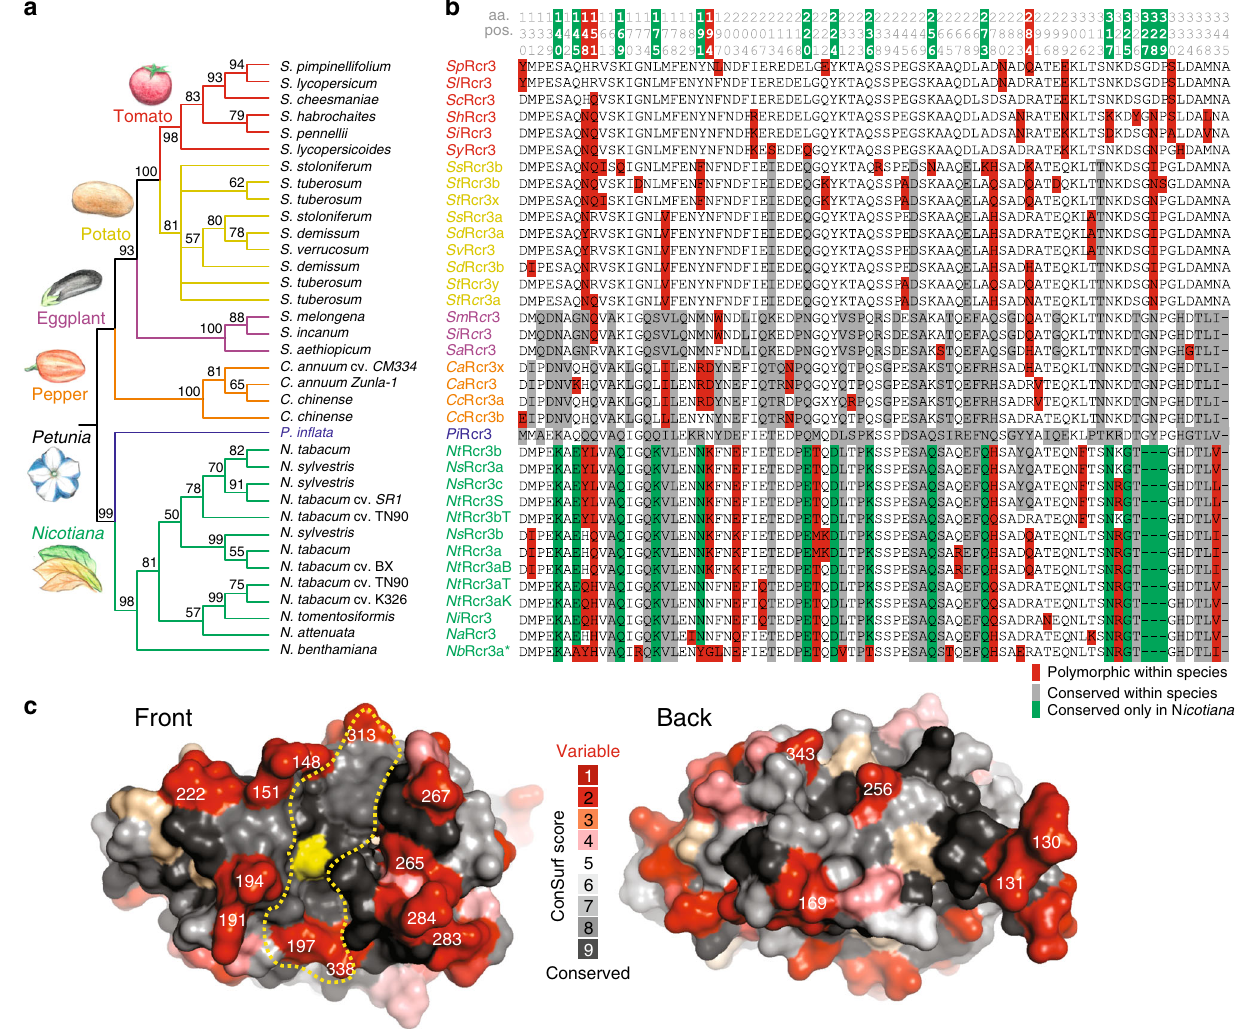
Fig. 4 Rcr3 is highly polymorphic in Solanaceae. a The evolutionary history of Rcr3 was inferred using the Maximum Likelihood method based on the Whelan and Goldman model. The bootstrap consensus tree inferred from 1000 replicates is taken to represent the evolutionary history. Shown are percentage bootstrap values. b Summary of variant residues in the protease domain. Columns with conserved residues or a single substitution are not shown. Highlighted are residues that are polymorphic within a genus (red) polymorphic within solanaceous plants but putatively fi xed within a genus (gray), and putatively fi xed only within Nicotiana (green). The residue position is indicated on top (e.g., fi rst residue is pos. 130) with the residues relevant for Avr2 binding highlighted in red and residues associated with HR in green. *, resurrected Nb Rcr3a* is not included in the annotation of Nicotiana -speci fi c sites (green). c Position of polymorphic residues in the 3D model of Rcr3. Sl Rcr3 was modelled on 1s4v and amino acid polymorphism were analysed by ConSurf and scores were used to color the structure using PyMol. Highlighted are the catalytic Cys residue (yellow) and substrate-binding groove (yellow dash line), as well as some of the most polymorphic residues (white